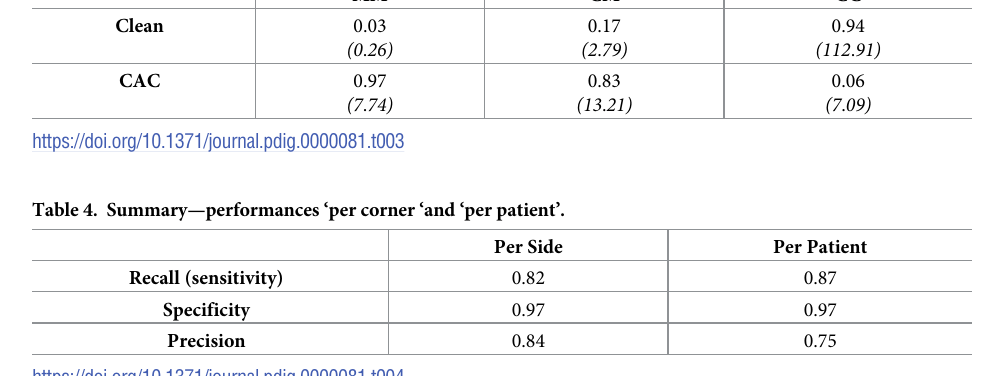
Table 3. The probabilities and quantities of prediction CAC or “Clean” on three types of patients based on the performance of a single side. The cells in the table consist of the probabilities and the patient numbers are presented in italic in parentheses.